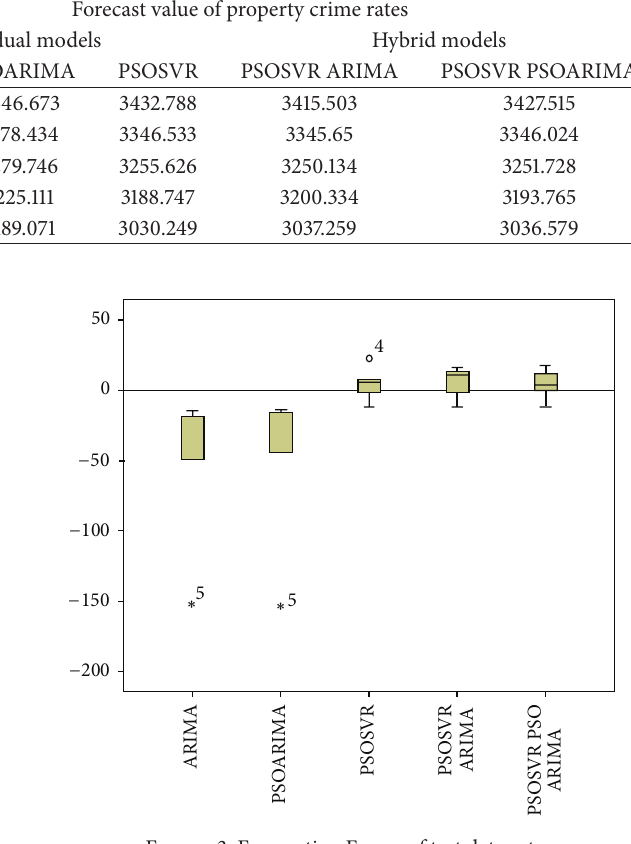
Figure 3: Forecasting Errors of test data set. Table 3: Comparison of